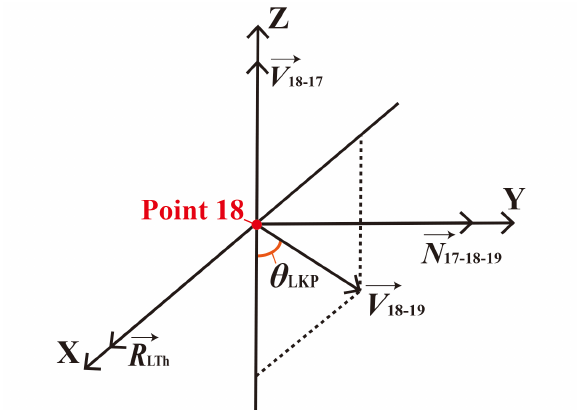
Figure 7. The link frame of the left lower torso of the human skeleton model and the hip joint angles for mapping.